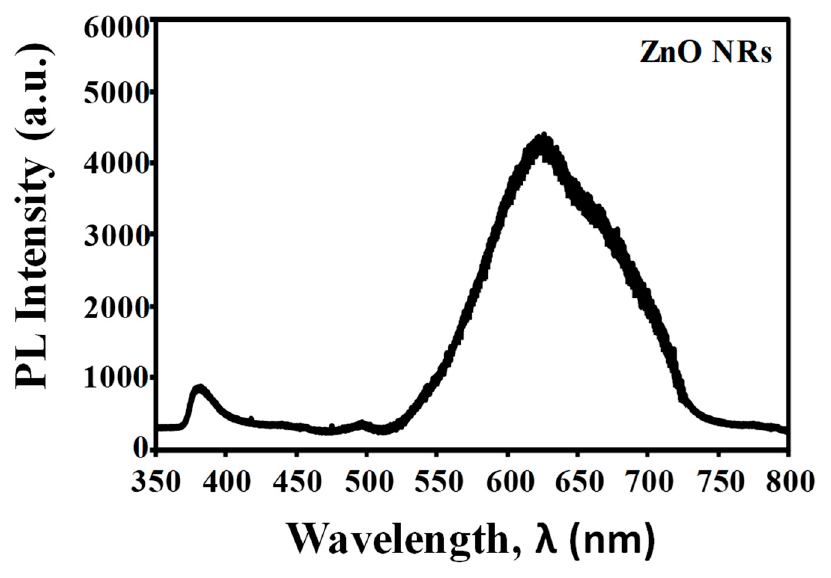
Figure 8. The PL spectrum of ZnO NRs obtained at an immersion time of 2 h.